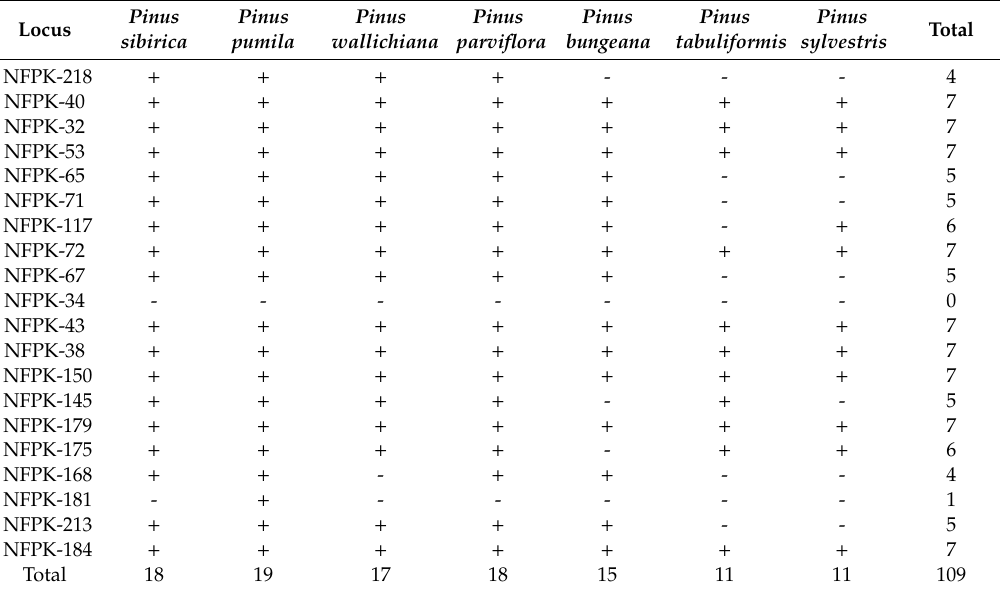
Table 5. Transferability in related species of Pinus using 20 EST-SSR primers developed from the cold-stressed transcriptome of Pinus koraiensis